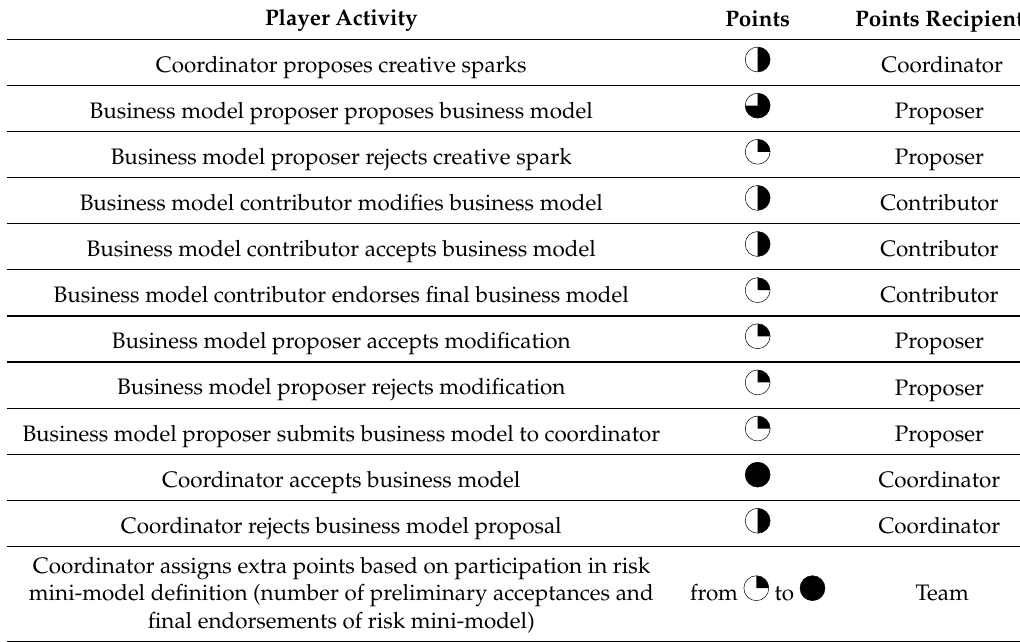
Table 1. Points won by the coordinator, proposers, and contributors for the performed activities aimed at business model definition. Harvey balls indicate the amount of points: indicates no points and indicates four